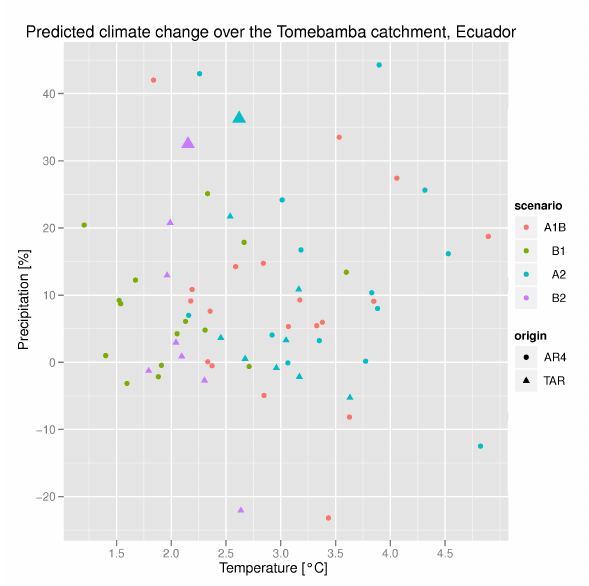
Fig. 3. Overview of the projected anomalies in yearly tempera- ture and relative precipitation for the study area according to cli- mate change assessment report and emission scenario for the period 2070–2099. TAR=IPCC Third Assessment Report (IPCC, 2001); AR4=IPCC Assessment Report 4 (IPCC, 2007); A1B, A2, B1 and B2 refer to the emission scenarios of the IPCC Special Report on Emissions Scenarios (IPCC, 2001). The larger triangles represent the PRECIS